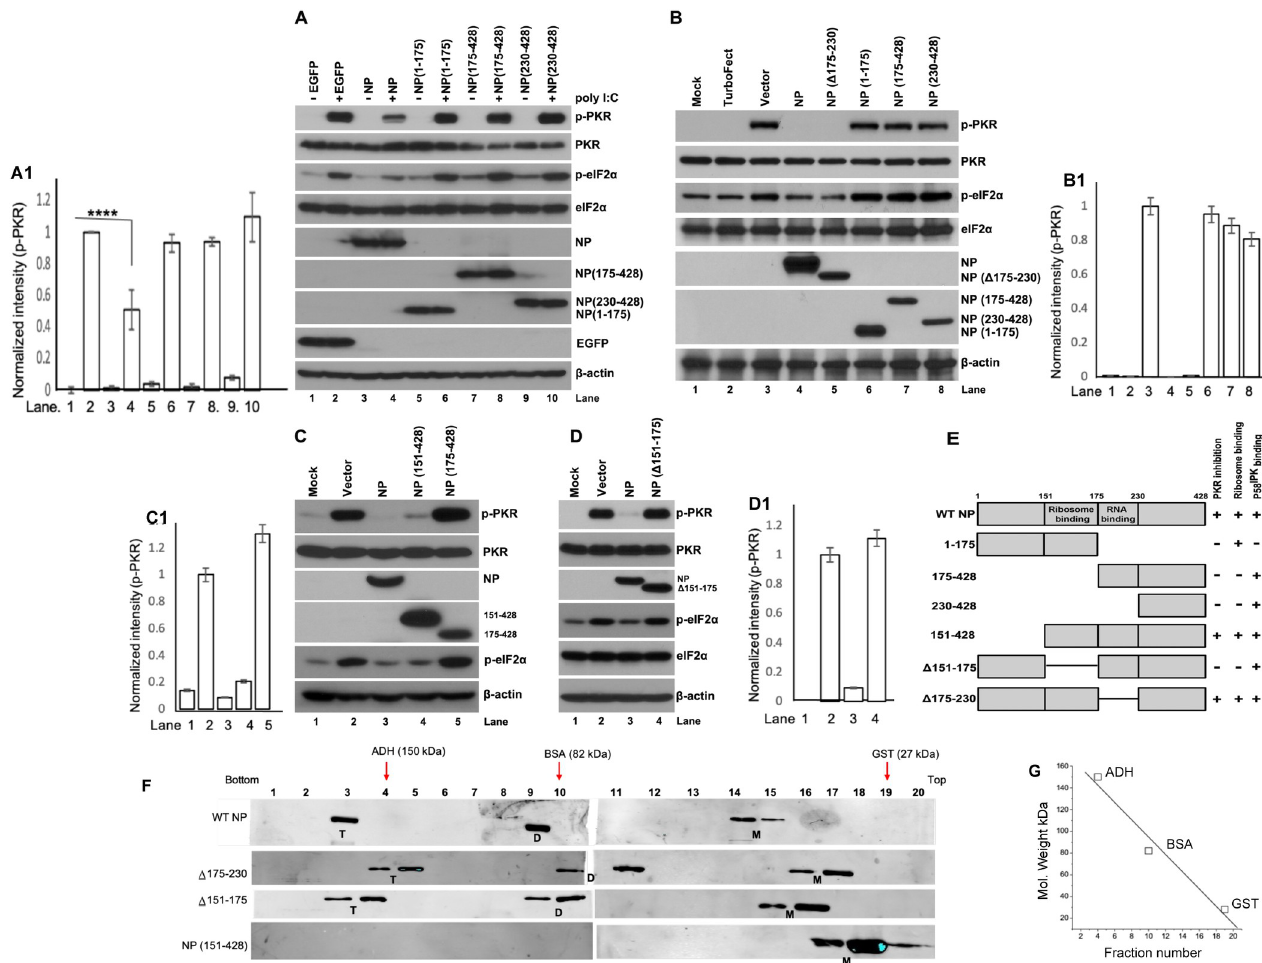
Fig 4. NP requires both RPS19 and P58 IPK binding domains to inhibit PKR. A . HEK293T stable cell lines expressing either EGFP or wild type NP or NP truncation mutants were either mock transfected or transfected with Poly I:C three hours before harvesting to stimulate PKR autophosphorylation. Cells were harvested and the expression of indicated proteins was examined by western blot analysis using appropriate antibodies. A1 . The band intensities of p-PKR in panel A were quantified by imageJ and normalized intensity values were plotted verses lane number, as discussed in panel Fig 1. B . HEK293T cells were either mock transfected or transfected with the transfection reagent (TurboFect) alone, or TurboFect containing empty vector (pcDNA3.1) or expression vectors expressing either wild type NP or NP deletion mutant lacking the RNA binding domain (NP Δ 175–230) of NP truncation mutants (NP1-175, NP175-428 or NP230-428). Cells were harvested and examined for the expression of indicated proteins using appropriate antibodies. B1 . The band intensities of p-PKR in panel B were quantified by imageJ and normalized intensity values were plotted verses lane number. Error bars are the ten percent of the normalized intensity value. C and D. HEK293T cells were either mock transfected or transfected with empty vector or expression vectors expressing wild type NP or NP truncation mutants NP151-428, NP175-428 (panel C) or deletion mutant lacking the RPS19 binding domain (NP Δ 151–175) (Panel D). Cell lysates were examined for the expression of indicated proteins using appropriate antibodies. C1 and D1 . The band intensities of p-PKR in panel C & D were quantified by imageJ and normalized intensity values were plotted verses lane number. Error bars are the ten percent of the normalized intensity value. E . Pictorial representation of wild type NP and NP mutants. The horizontal line represents the deleted region from the amino acid sequence. F . Sucrose density gradient centrifugation to examine the oligomerization forms of wild type NP and its mutants. The proteins (GST, BSA, ADH, W.t NP, Δ 175–230, Δ 151–175, NP(151–428)) were fractionated on 5–50% sucrose gradient and gradient fractions were examined by western blot analysis. Note: M, D and T represents the monomeric, dimeric and trimeric forms of the protein, based on the Molecular weight determination using Fig 4G. G . A plot of molecular weight of GST, BSA and ADH verses the fraction number in which these proteins eluted in the gradient. The fractions in which these proteins eluted in the gradient are also shown by red arrows in Fig 4F.